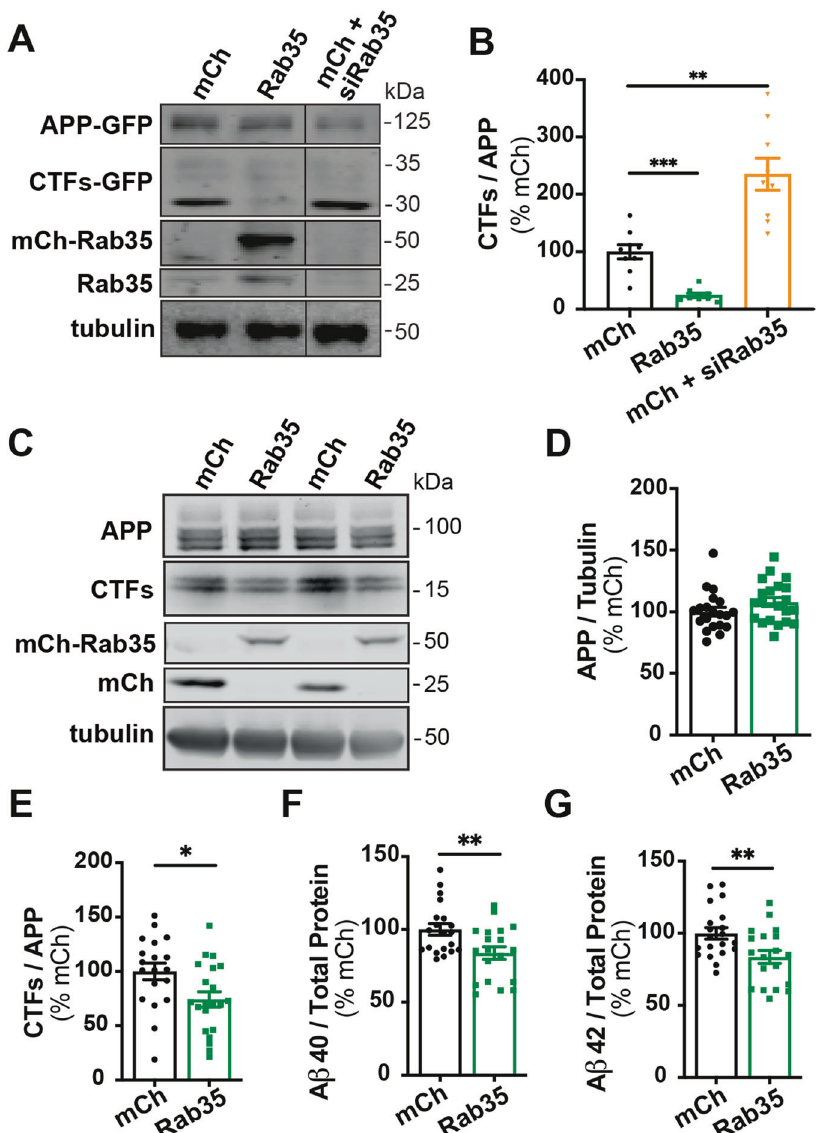
Fig. 2 Rab35 expression suppresses APP processing. A , B Representative immunoblots and quanti fi cation of APP CTFs from N2a cells co- expressing APP-GFP with mCherry, mCh-Rab35, or mCh + siRNAs against Rab35 (siRab35). Immunoblots were probed for GFP, tubulin, and Rab35, with values normalized to tubulin and expressed as % of mCh control (*** P mChCtrl vs. mCh-Rab35 = 0.0006, ** P mChCtrl vs. mCh + siRab35 = 0.0029; one-way ANOVA with Welch ’ s correction, n = 9 samples/condition, 1 experiment). C – E Representative immunoblots and quanti fi cation of APP CTFs from iPSC-derived cortical neurons expressing mCh or mCh-Rab35. Blots were probed for APP, tubulin, and mCherry, with values normalized to tubulin and expressed as % of mCh control (* P = 0.017; unpaired t -test, n = 19 – 21/condition, four independent cultures). F , G Measurement of A β peptides secreted by iPSC-derived human neurons transduced with mCherry or mCh-Rab35. Values are normalized to total protein and expressed as % of mCh control (** P A β 40 = 0.008, ** P A β 42 = 0.009; unpaired t -test, n = 19 – 20 samples/condition, four independent cultures). All numeric data represent mean ±